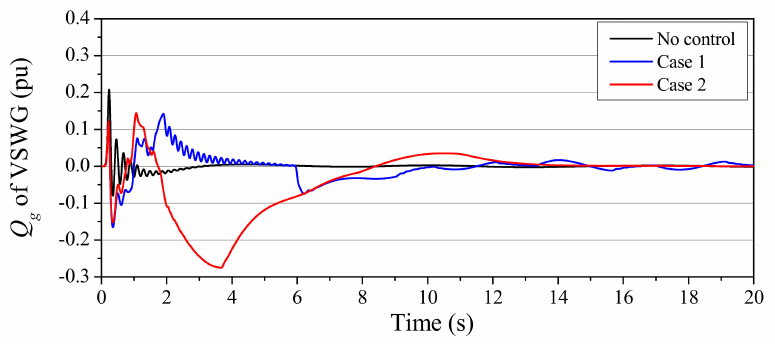
Figure 13. Reactive power of the VSWG (with SG3